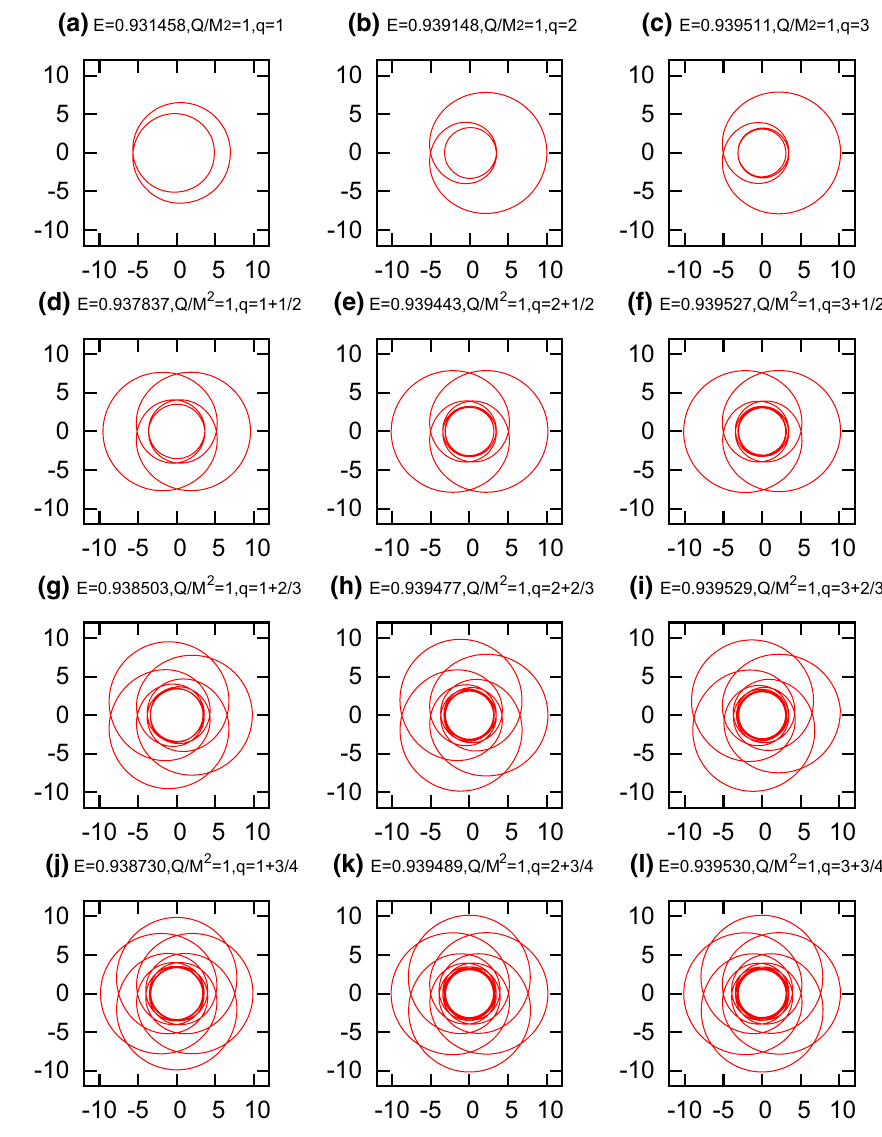
Fig. 12 Zoom-whirl periodic orbits ( z ,w,ν) around the DMPR brane-world black holes with Q = M 2 with (cid:14) = 0 . 3